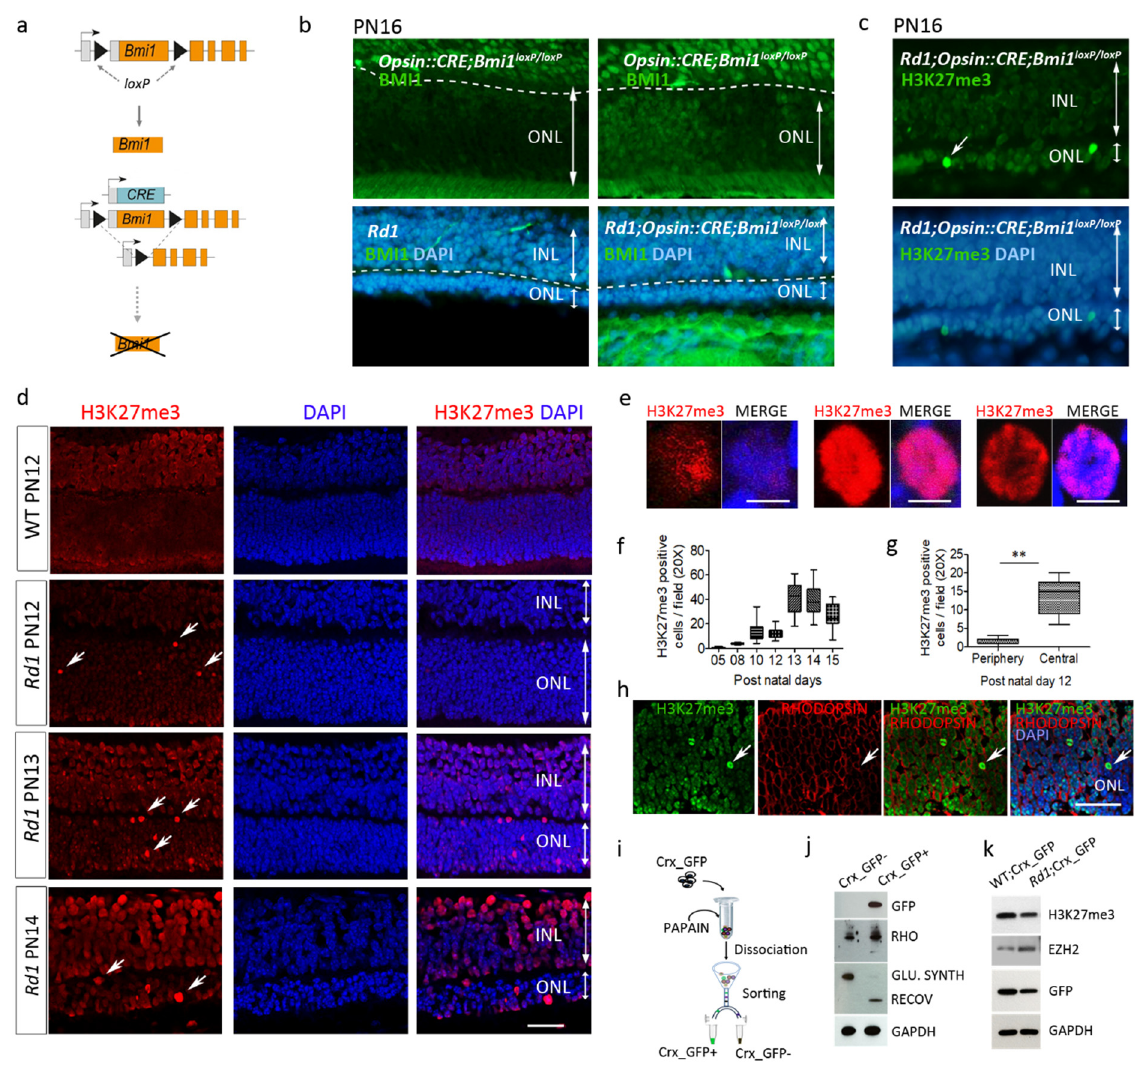
Figure 1. Photoreceptor degeneration is associated with increased H3K27me3 mark in Rd1 mice. ( a , b ) Conditional Bmi1 deletion driven by the photoreceptor-specific opsin promoter has no effect on photoreceptor degeneration in Rd1 . ( a ) Schematic representation of genetic manipulations performed on Rd1;Opsin::CRE;Bmi1 loxP/loxP mice. Black triangles indicate loxP sites that surround the Bmi1 gene. ( b ) The Opsin::CRE;Bmi1 loxP/loxP animal shows a specific deletion of Bmi1 within the ONL in a mosaic pattern (2 top panels). No rescue of photoreceptors was seen in Rd1;Opsin::CRE;Bmi1 loxP/loxP at PN16 compared to the Rd1 control mice (2 bottom panels). ( c ) Accumulation of the H3k27me3 mark was observed in some degenerating Rd1;Opsin::CRE;Bmi1 loxP/loxP photoreceptors at PN16. ( d ) The abundance, distribution (white arrows) and nuclear localization of high H3K27me3 (H3K27me3 h )-positive cells are age-dependent in Rd1 retina (red staining). ( e ) Diverse patterns of H3K27me3 h expression in the photoreceptor nuclei during the degenerative course. ( f ) The number of H3K27me3 h positive cells in Rd1 mice increases from PN8 with the severity of the disease, peaks at PN13 and was shown to initiate in the central retina ( g ). ( h ) H3K27me3 accumulation occurs in rod cells, as demonstrated by H3K27me3 h and RHODOPSIN (Rho, red labelling, arrows) staining colocalization. The dissociation and sorting ( i ) of the GFP-positive cells allows to isolate photoreceptors from the Crx-GFP models, as confirmed by Western blot analysis ( j ). ( k ) Western blot of isolated photoreceptors from the Crx-GFP and Rd1;Crx-GFP PN12 retina reveals increased expression of EZH2 in degenerating photoreceptors. Histograms and plots are from an average of at least 8 sections, n = 4 animals per group. Statistical analysis: ANOVA t test, p < 0.01 (**). Error bars indicate SEM. ONL = outer nuclear layer, INL = inner nuclear layer. Scale bars = 40 μ m ( d , h ).